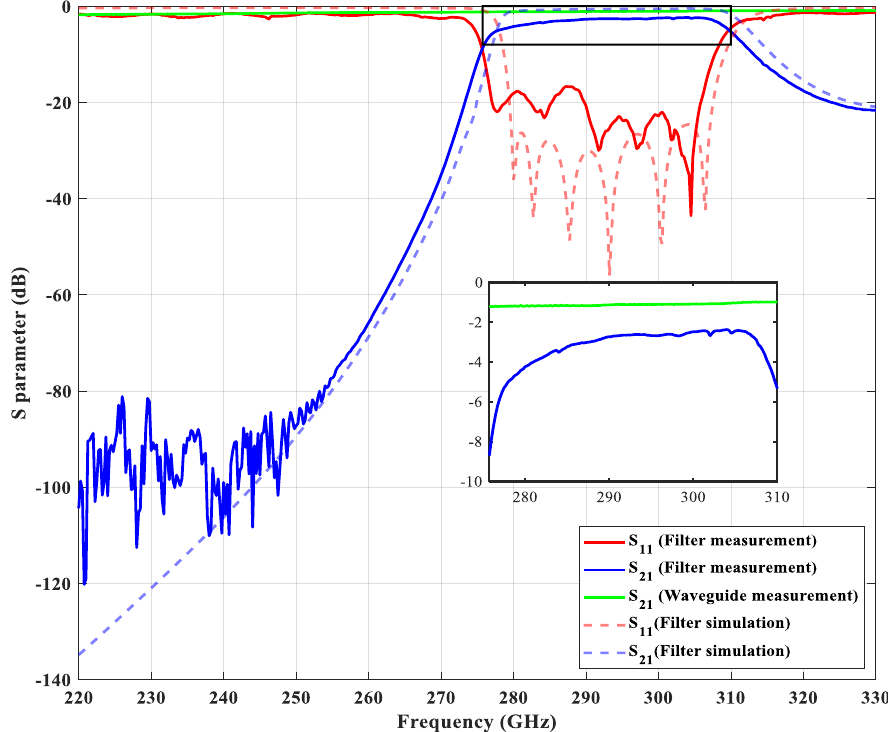
Figure 6. The simulation and measurement results of the proposed waveguide bandpass filter and the measured response of a straight waveguide for comparison.